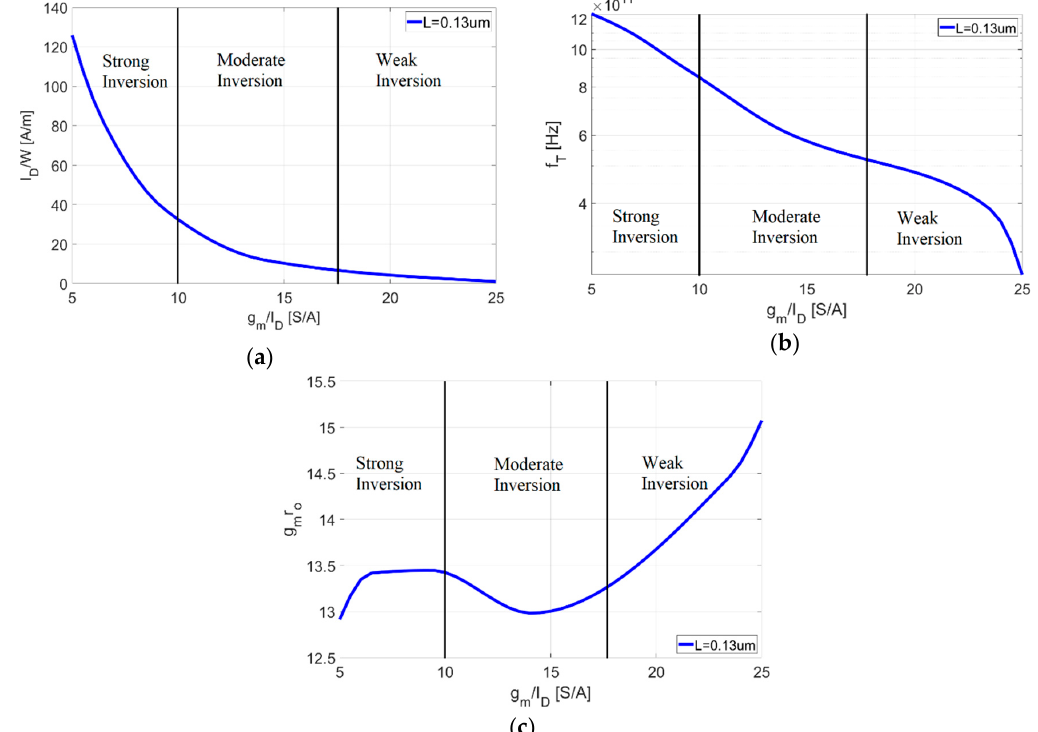
Figure 3. IHP 0.13 μ m process lookup tables ( a ) current density I D /W vs. g m /I D ; ( b ) transit frequency Figure 3. IHP 0.13 µ m process lookup tables ( a ) current density I D / W vs. g m / I D ; ( b ) transit frequency f T vs. g m /I D ; and ( c ) intrinsic gain g m /g DS vs. g m /I D . f T vs. g m / I D ; and ( c ) intrinsic gain g m / g DS vs. g m / I D .